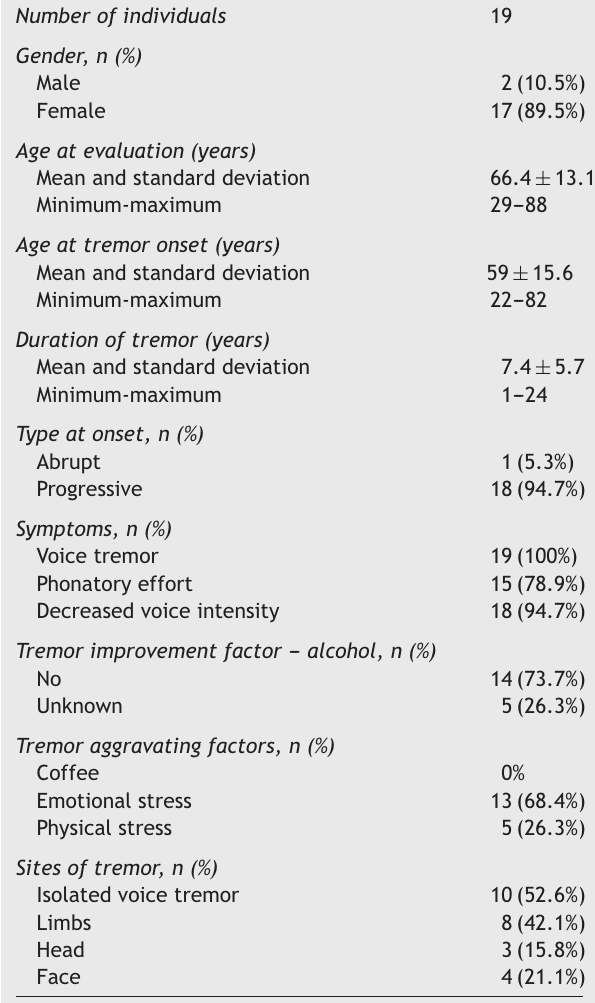
Descriptive analysis of the clinical and demo- graphic characteristics of individuals with voice tremor in the assessed